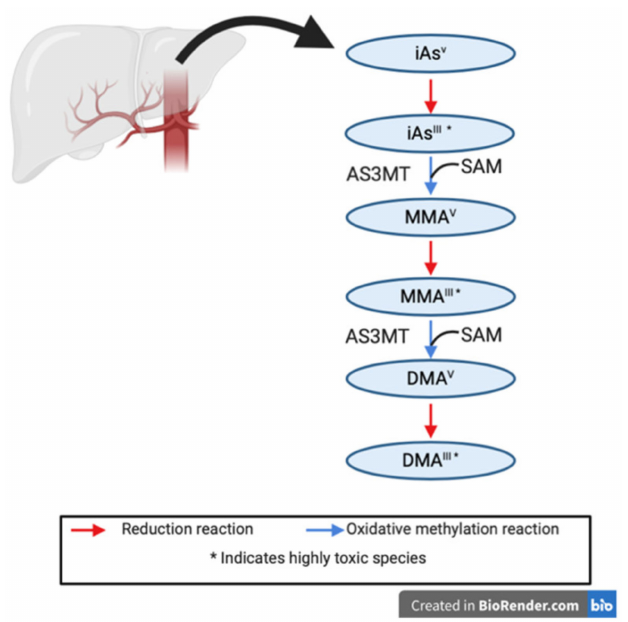
Figure 1. Inorganic arsenic metabolism pathway as proposed by Challenger, 1947. Inorganic arsenic metabolism occurs in the liver, by a series of oxidative methylation and reduction steps. Methylation occurs using the arsenic-3-methyltransferase (AS3MT) enzyme, and methyl donor S-adenosylmethionine